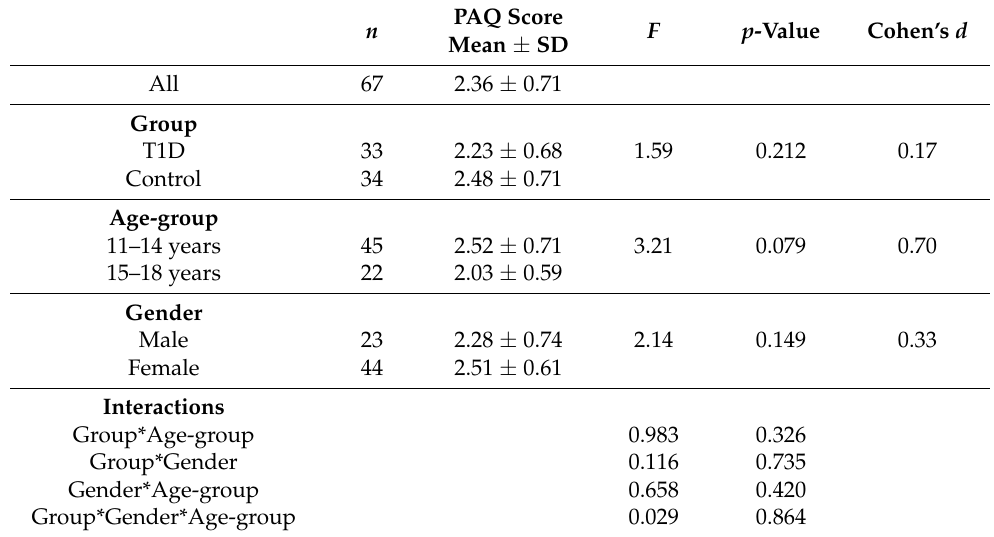
Table 3. Results of 3-way ANOVA comparing PAQ scores by group, age-group and gender.